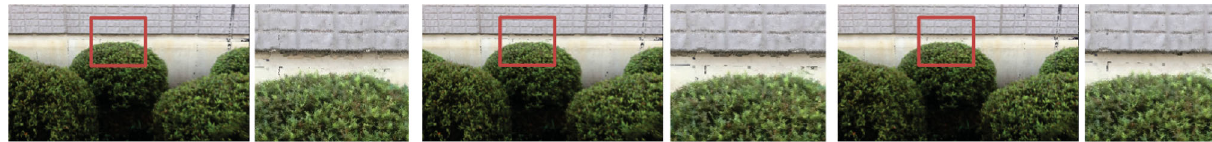
Fig. 11 Background restoration for consecutive frames of Scene